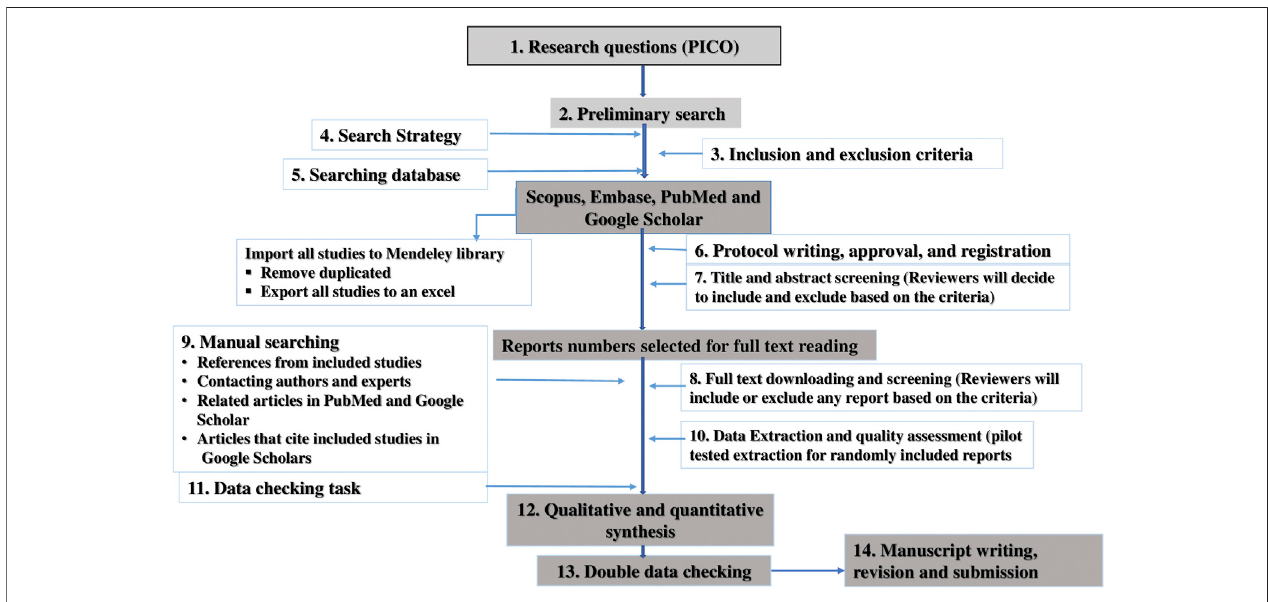
FIGURE 1 | A step by step fl ow diagram to conduct the